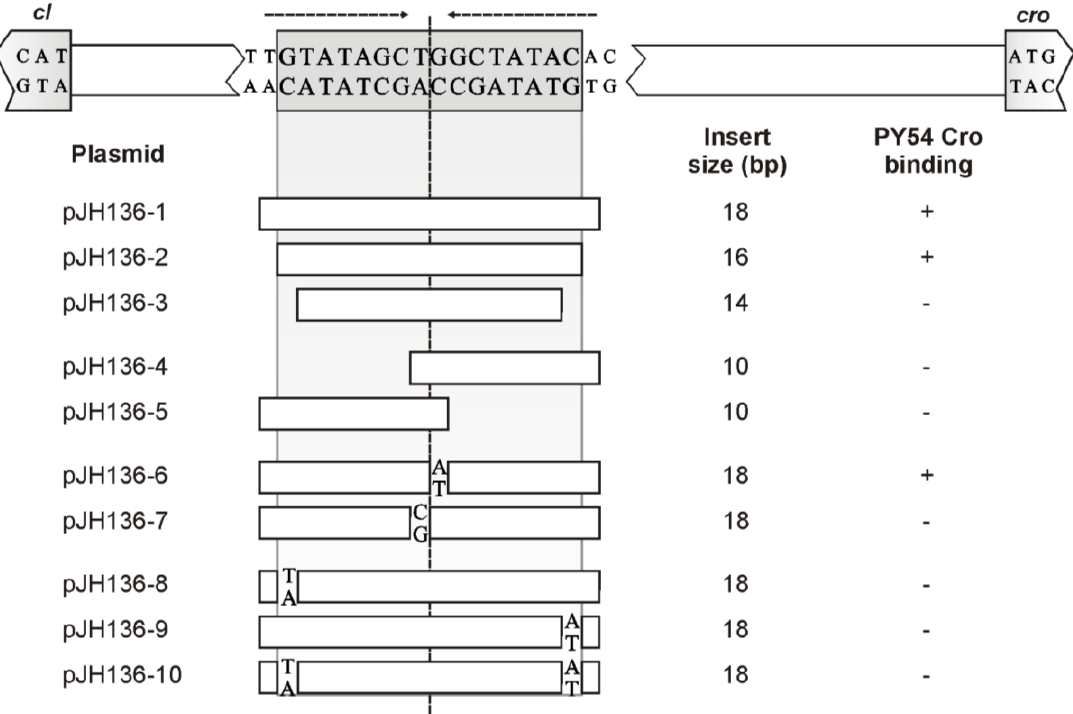
Figure 5. Sequence requirements and mutational analysis of the PY54 Cro binding site. At the top the nucleotide sequence of the upstream region of the prophage repressor gene cI is shown. The O 3 site exhibiting two-fold rotational symmetry is boxed. Arrows R represent nucleotides with two-fold rotational symmetry. The lower part lists the substrates used for binding assays. Base pair exchanges in mutants are indicated. On the